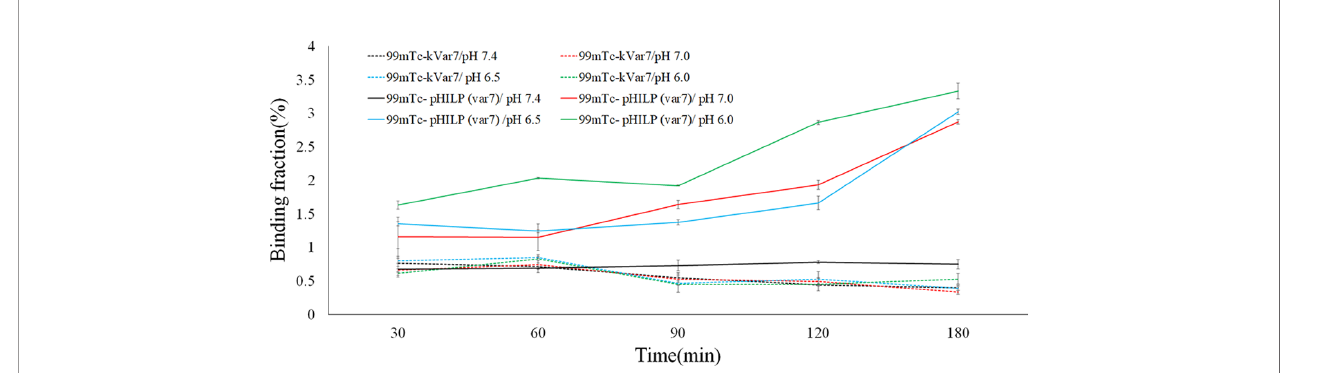
FIGURE 3 | Binding fraction of 99m Tc-pHLIP (Var7) and 99m Tc-kVar7 to MDA-MB-231 cells at different times and at different pH values (n=3).